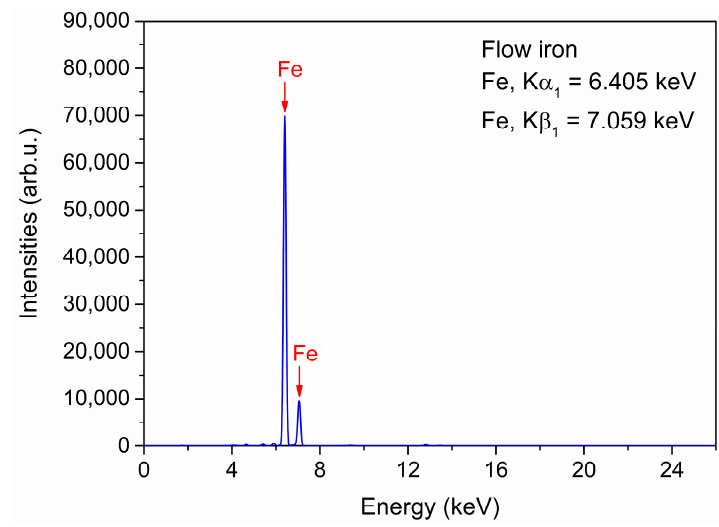
Figure 2. The XRF analysis of the purity of the ZVI.